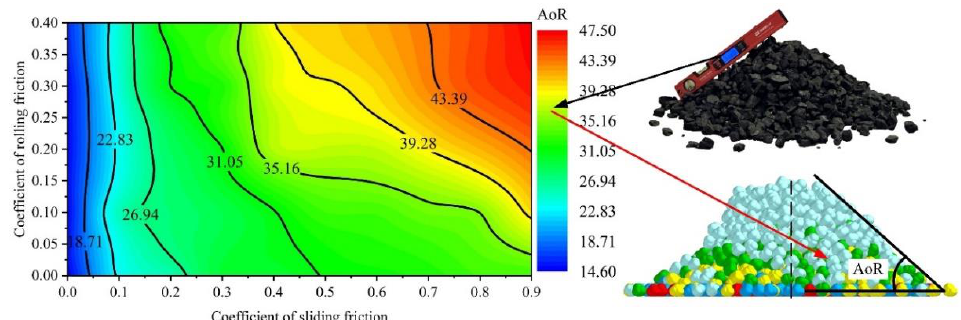
Figure 7. Experimental and numerical results of AoR.